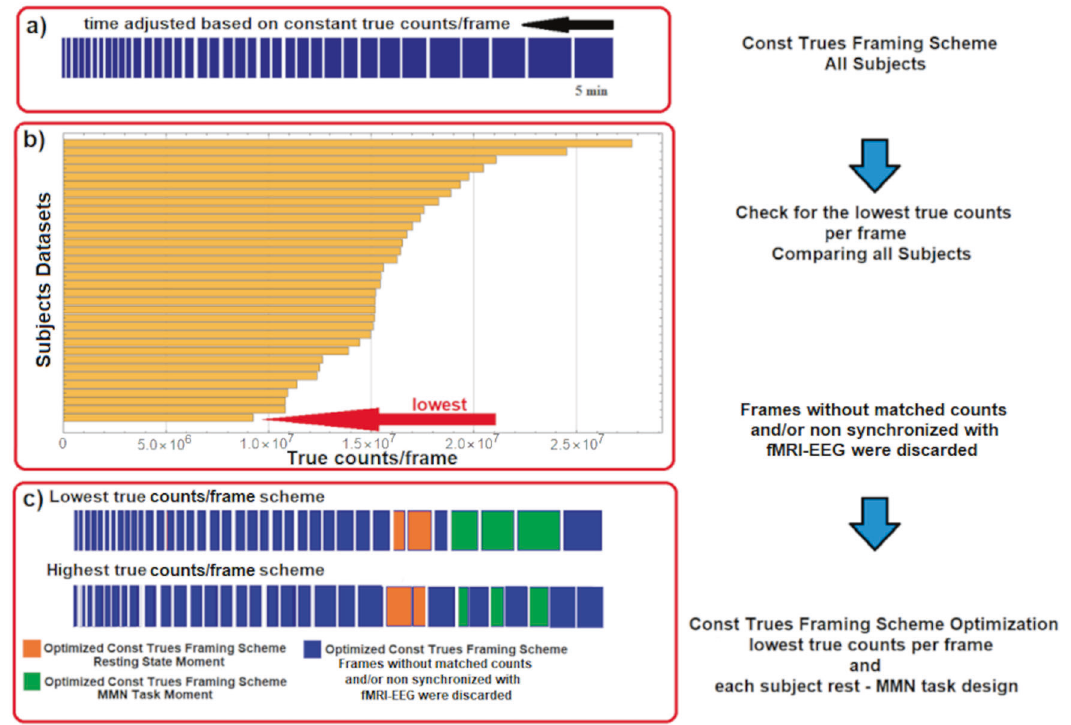
Fig. 2 PET-matched framing scheme applied in this [ 11 C]ABP688 study. a General frame scheme with variable time-frame lengths, enabling constant true counts/frame. b Comparison of all subjects to fi nd the lowest-average true counts per frame. c Two individual Const Trues framing schemes showing the optimization to match the lowest-average true counts per frame between subjects and synchronized with the different acquisition moments: pretask resting state and the MMN task.